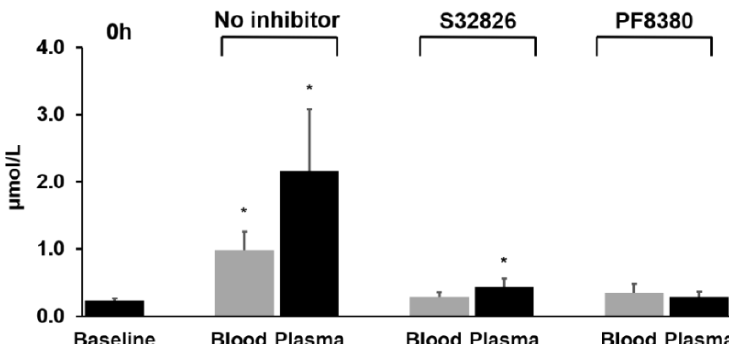
Figure 4. Changes in the contents of LPA(18:2) in whole blood and plasma after the addition of each autotaxin inhibitor and incubation at room temperature for 4 h. * p < 0.01 for comparison of LPA(18:2) vs. baseline.